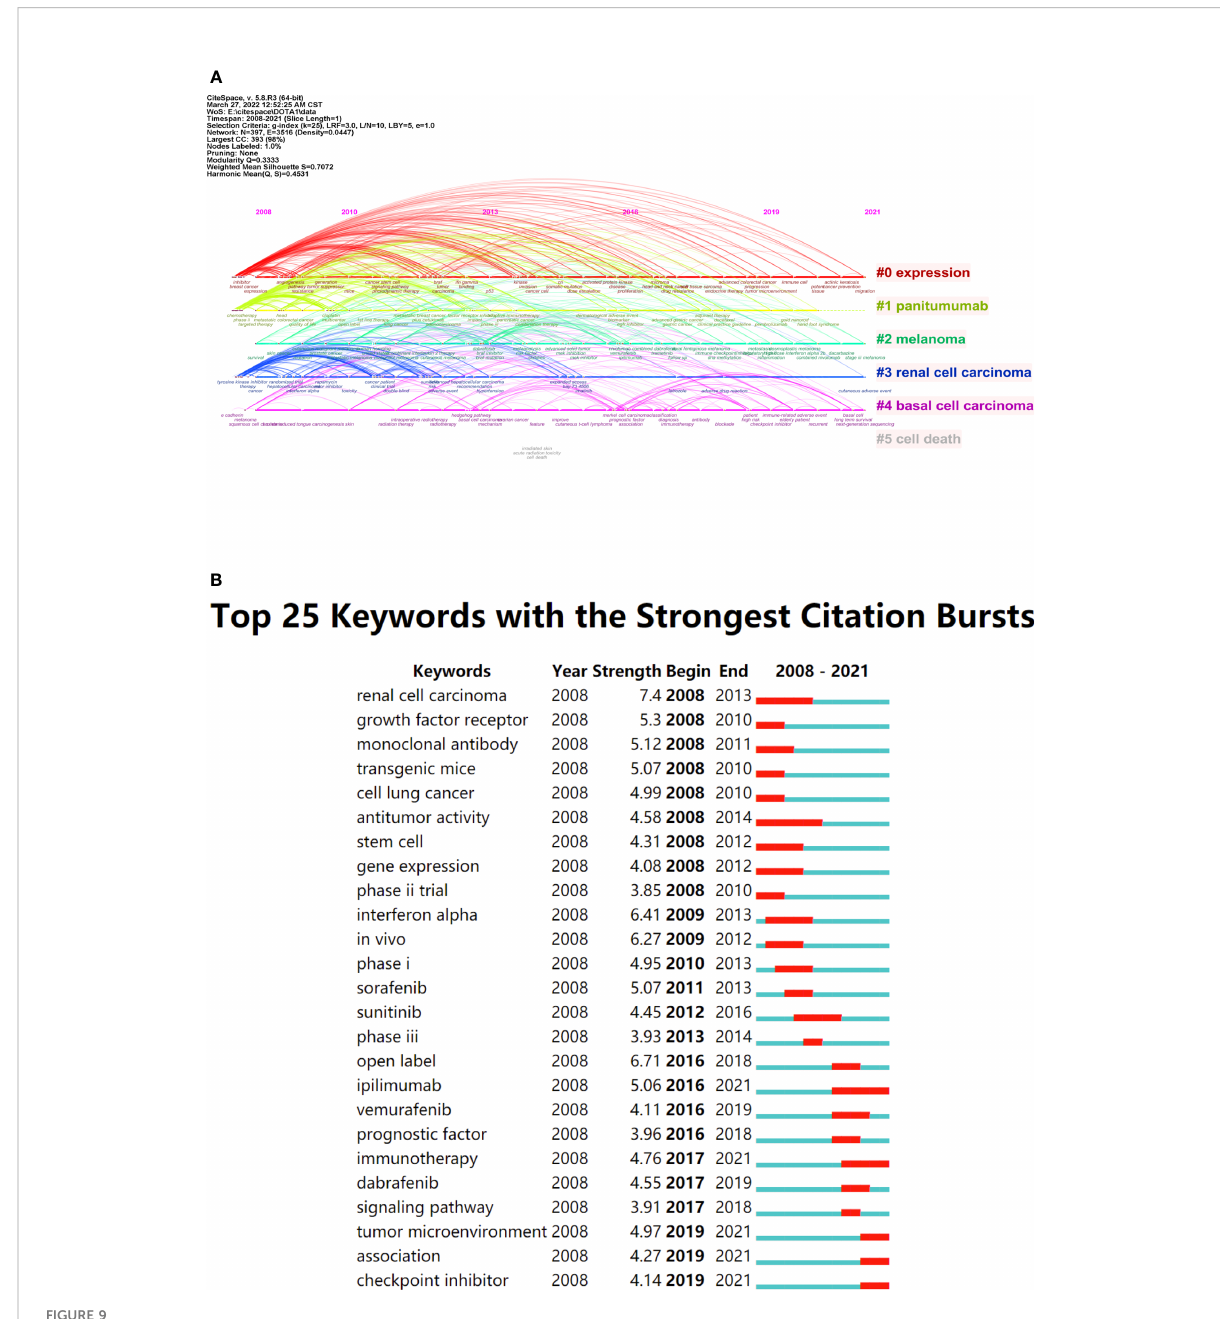
FIGURE 9 (A) Timeline view of keywords from publications generated by CiteSpace V (version5.8 R3). (B) The top 25 keywords with the strongest citation bursts of publications (The green line segment represents the time interval, and the red line segment represents the active